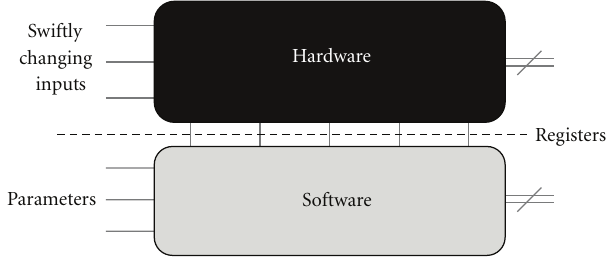
Figure 2: Conventional hardware/software partitioning.